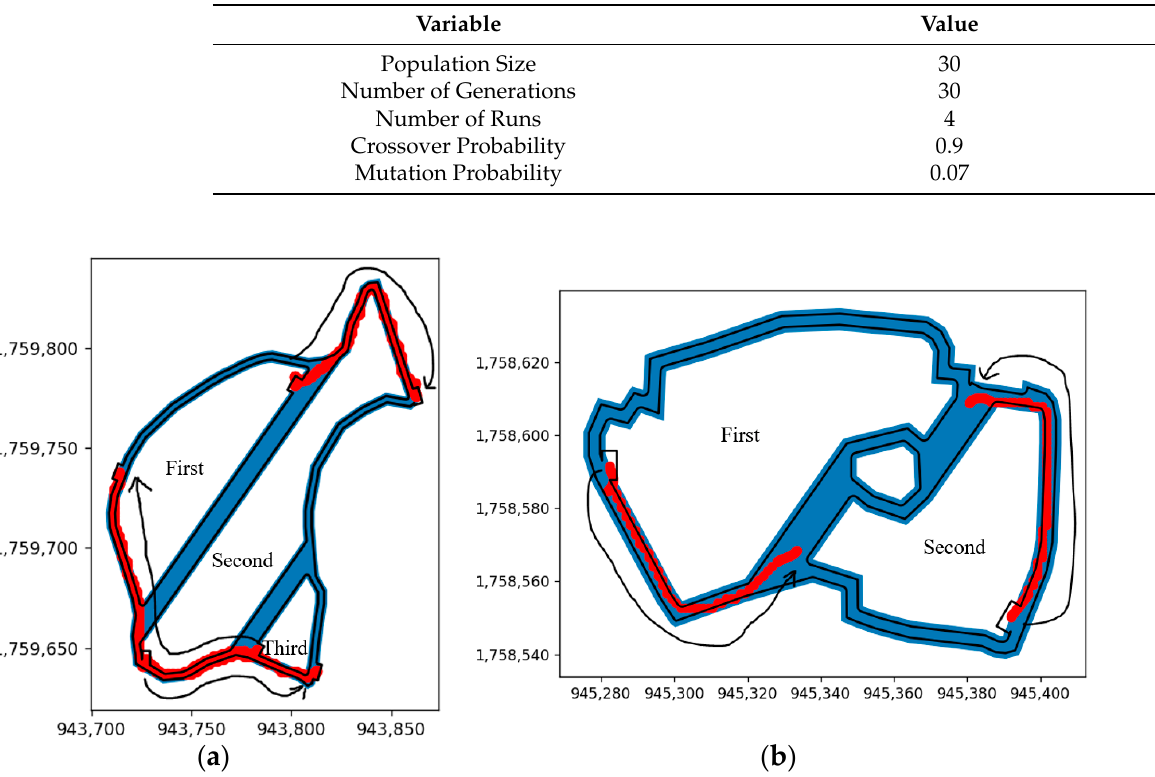
Figure 17. (a) Case A optimized subfield connecting paths; (b) Case B optimized subfield connecting Figure 17. ( a ) Case A optimized subfield connecting paths; ( b ) Case B optimized subfield connecting paths. paths.